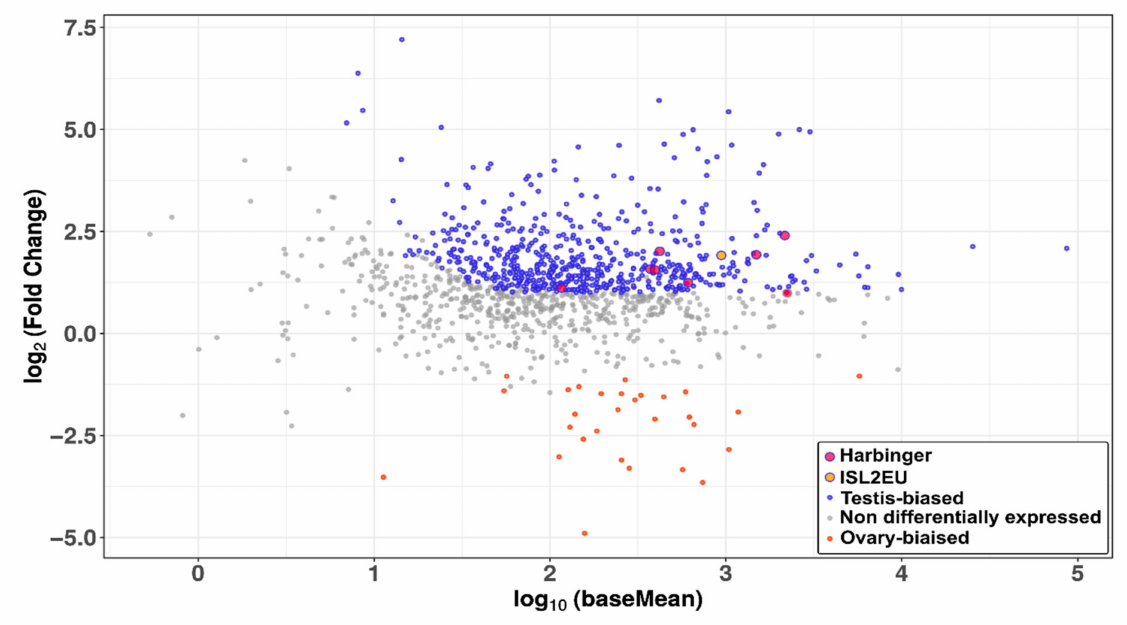
Figure 7. MAplot representing the relative expression in male and female gonads of all TE families of the medaka genome. Each dot corresponds to the relative expression of one TE family in RNAseq data. The x-axis corresponds to the signal intensity averaged across all replicates, and the y-axis to the log2 fold change of expression between testis and ovary (log2FC). The higher the log2FC of a TE family, the more it is over-expressed in testes (significant over-expression in testes is indicated in purple), and the lower it is, the more it is over-expressed in ovaries (significant over-expression in ovaries is indicated in orange). The further the gene is on the right, the more it is expressed overall, across all replicates. The Harbinger and ISL2EU families are highlighted with bigger red- or yellow-colored dots,